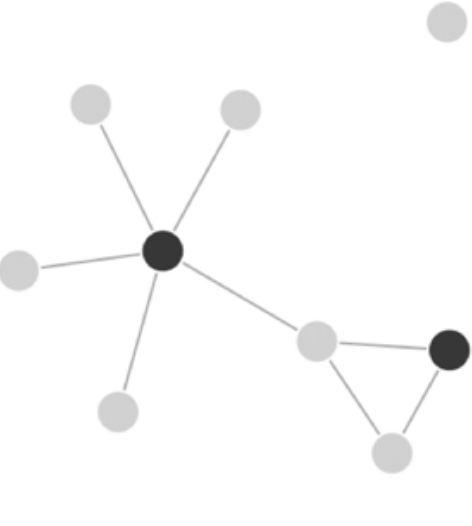
Figure 2. Sample visualization of a social network with 9 members. Regular members are indicated as light circles, and peer leaders are indicated as dark circles. Interactions are represented by straight, connective